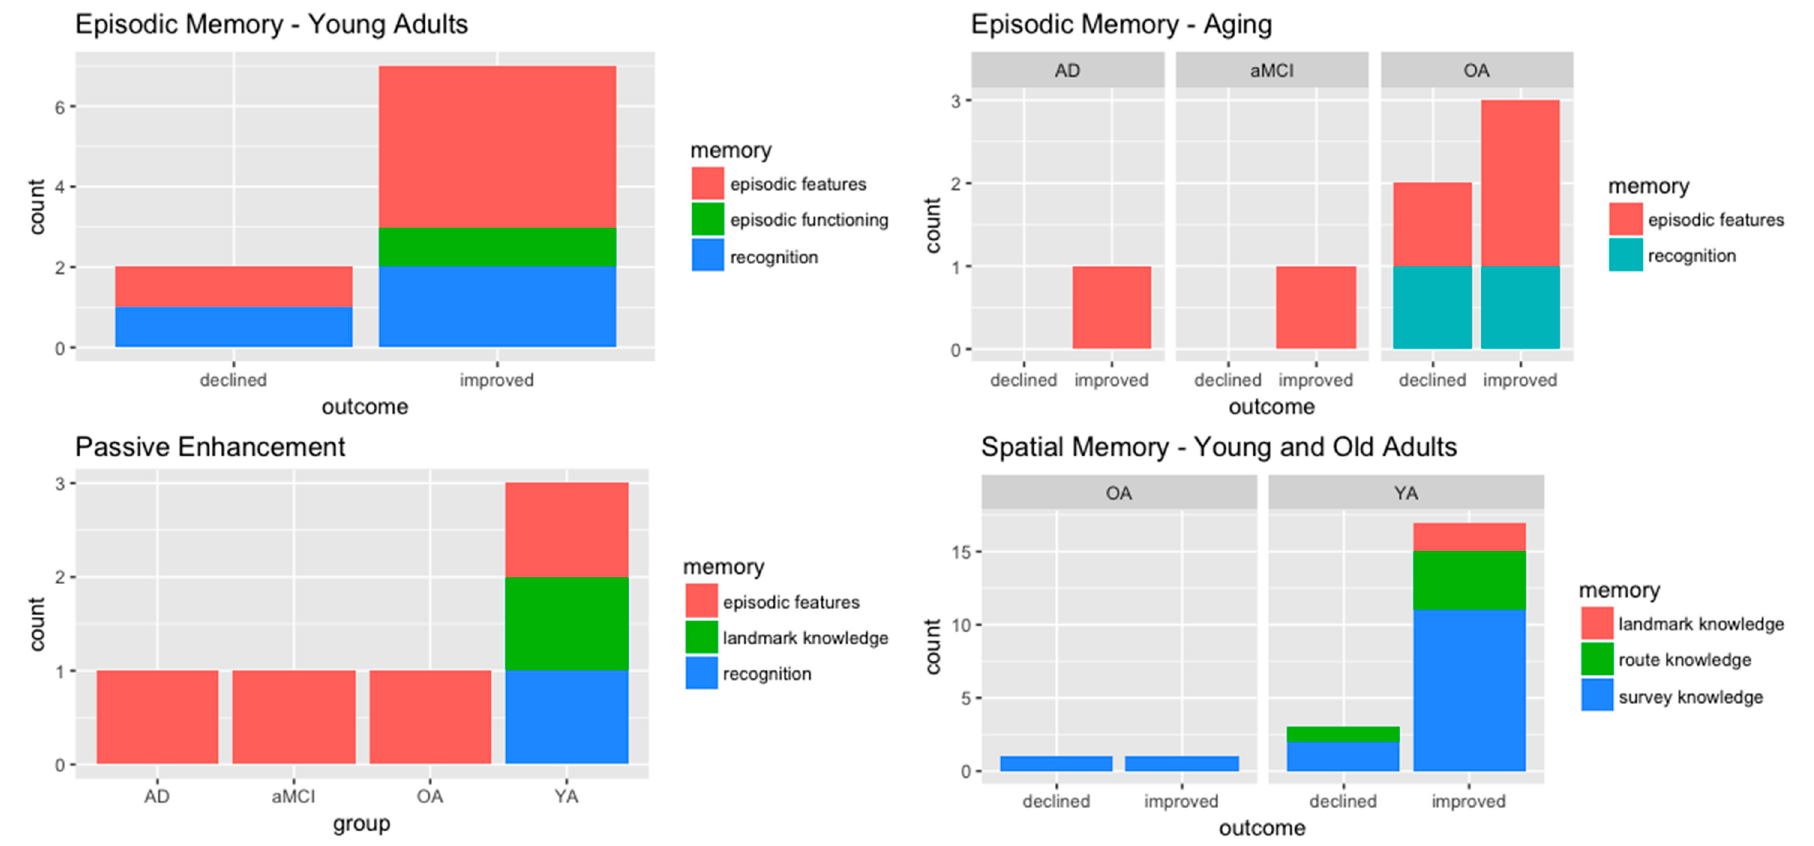
Figure 2. Summary of virtual enactment effect and passive enhancement in the samples. YA: young adults; OA: older adults; aMCI: amnestic mild cognitive impairment; AD: Alzheimer’s disease